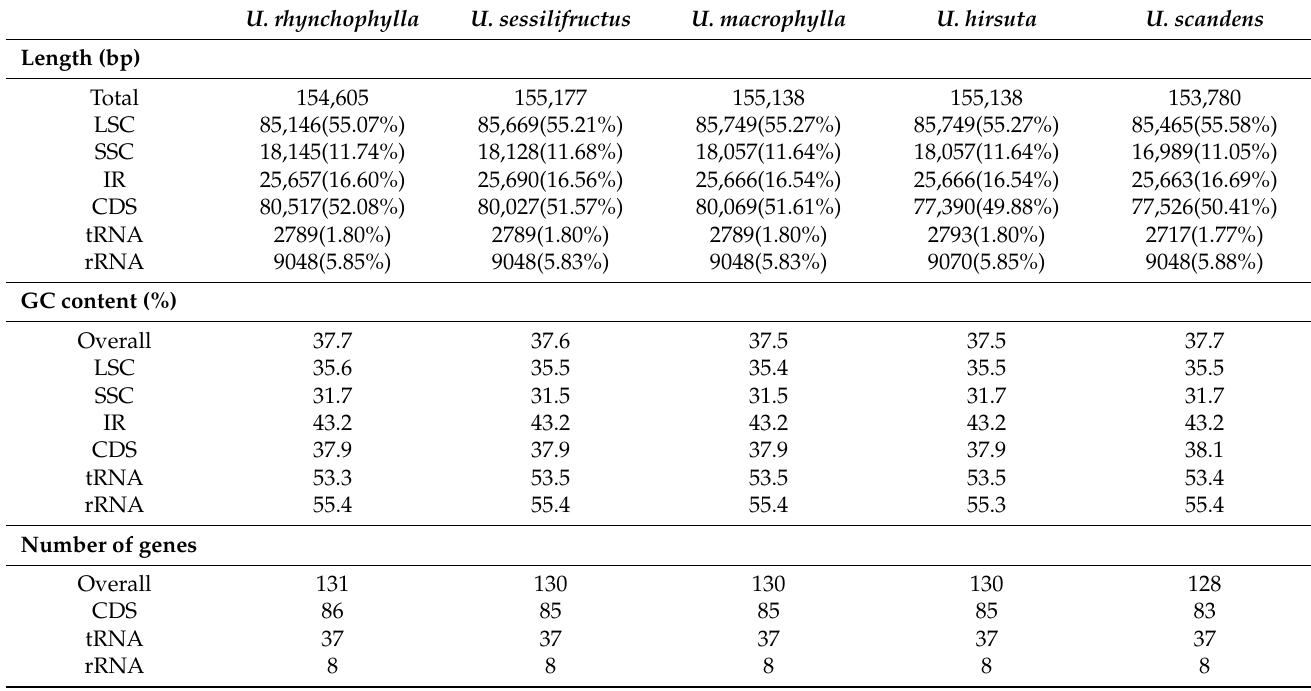
Table 2. Comparison of chloroplast genomic characteristics among five Uncaria species.